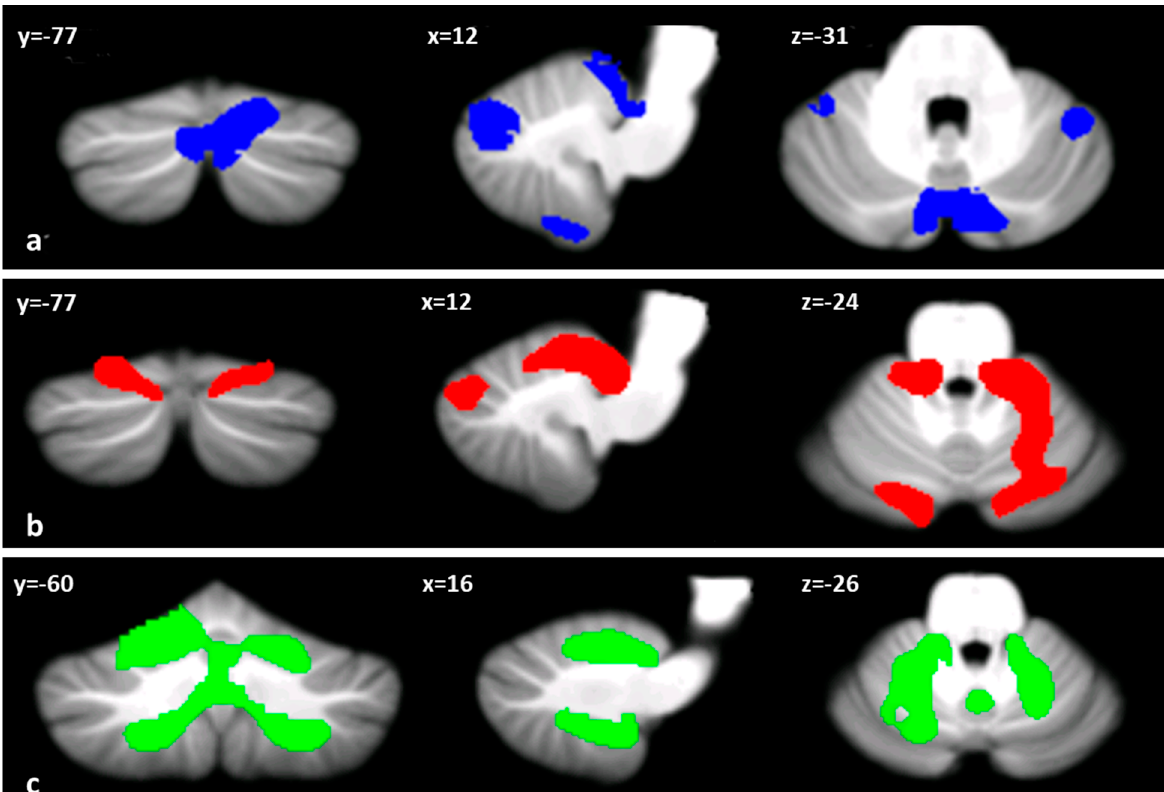
Figure 1. Cerebellar regions showing patterns of significantly reduced cerebellar grey matter (GM) are reported and superimposed on the spatially unbiased infratentorial template (SUIT) [51] in coronal (y), axial (z) and sagittal (x) sections. ( a ) BD < HS (in blue); ( b ) CD < HS (in red); ( c ) CD < BD (in green). The results are considered significant at p -values < 0.05 FWE corrected at the cluster level. Images are shown in the radiological convention.